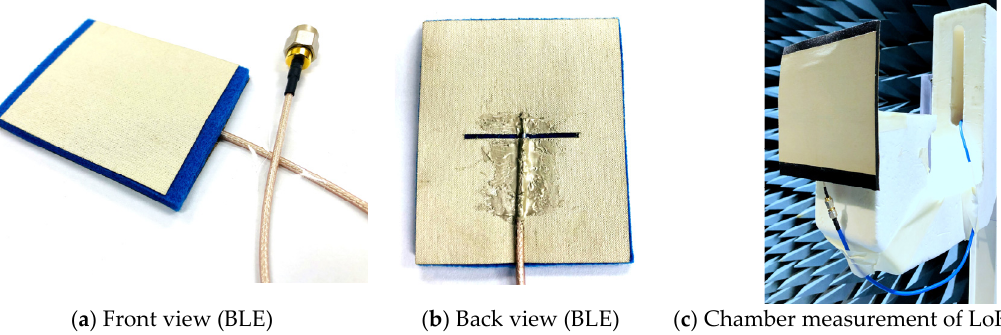
Figure 8. Photos of fabricated BLE antenna model.